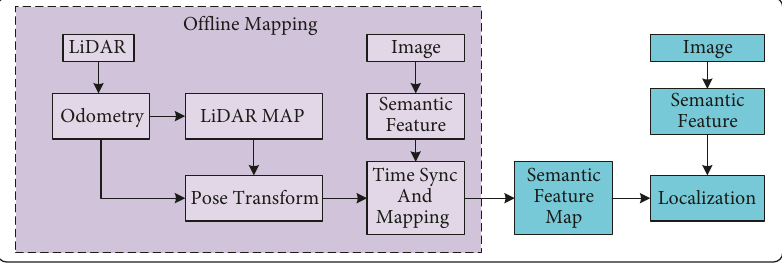
Figure 2: System